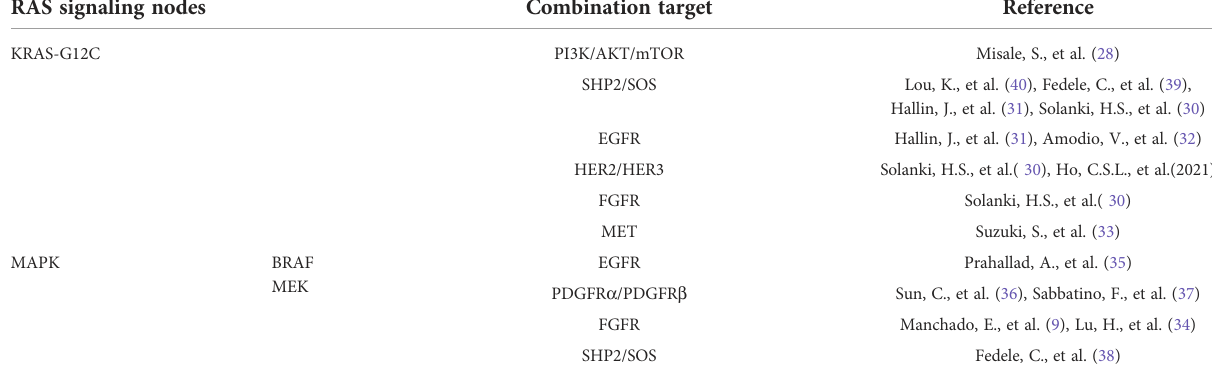
TABLE 2 Targets and strategies to improve the ef fi cacy of KRAS G12C